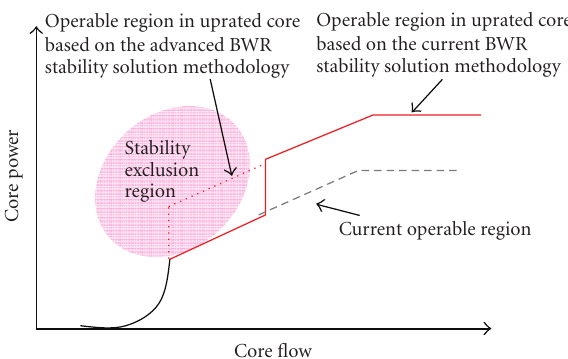
Figure 13: Plant operable region for the power-uprated